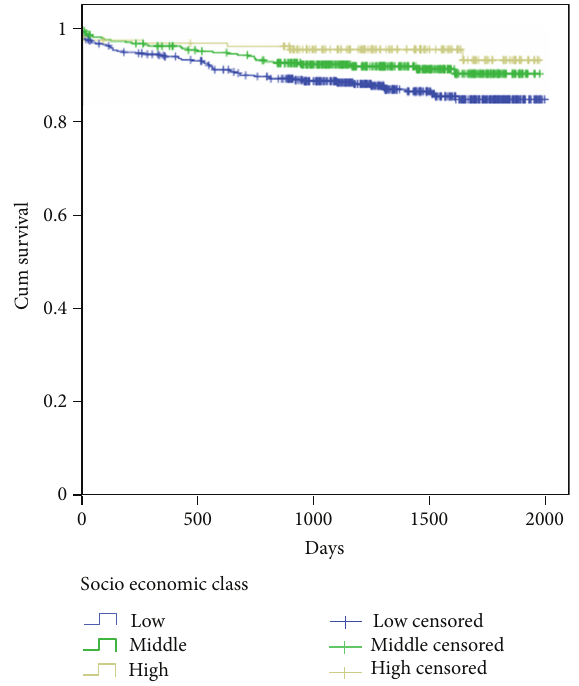
Figure 2: Kaplan-Meier plots depicting cardiac mortality during 5- year follow-up in individual socioeconomic groups, based on the total patient